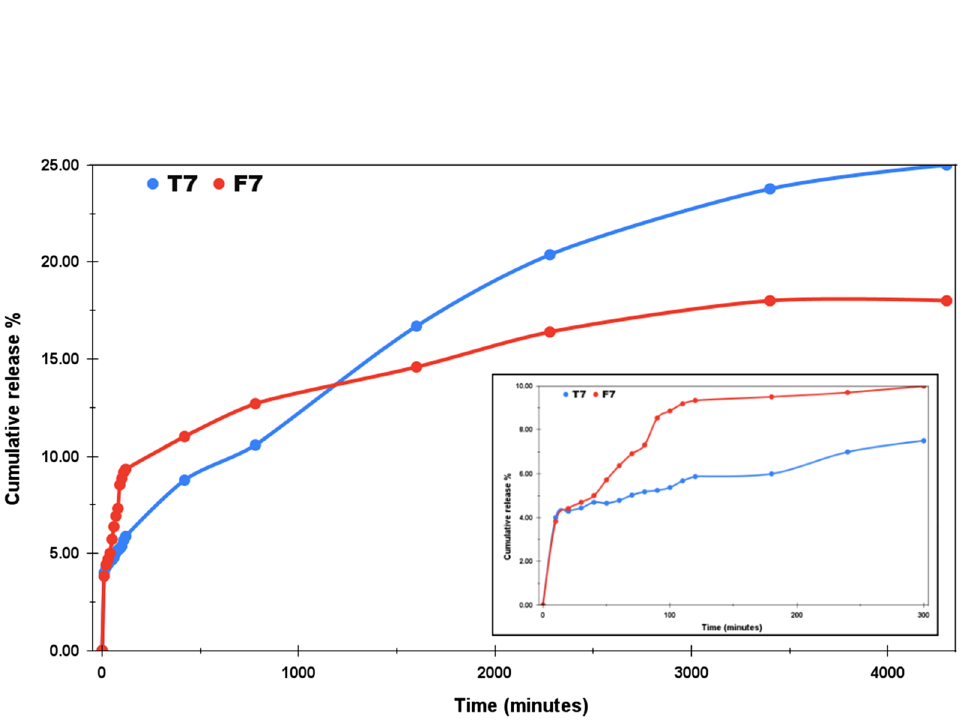
Figure 7. The Imatinib release profiles of Drug/TiO 2 NPs and Drug/Fe@TiO 2 NPs at pH